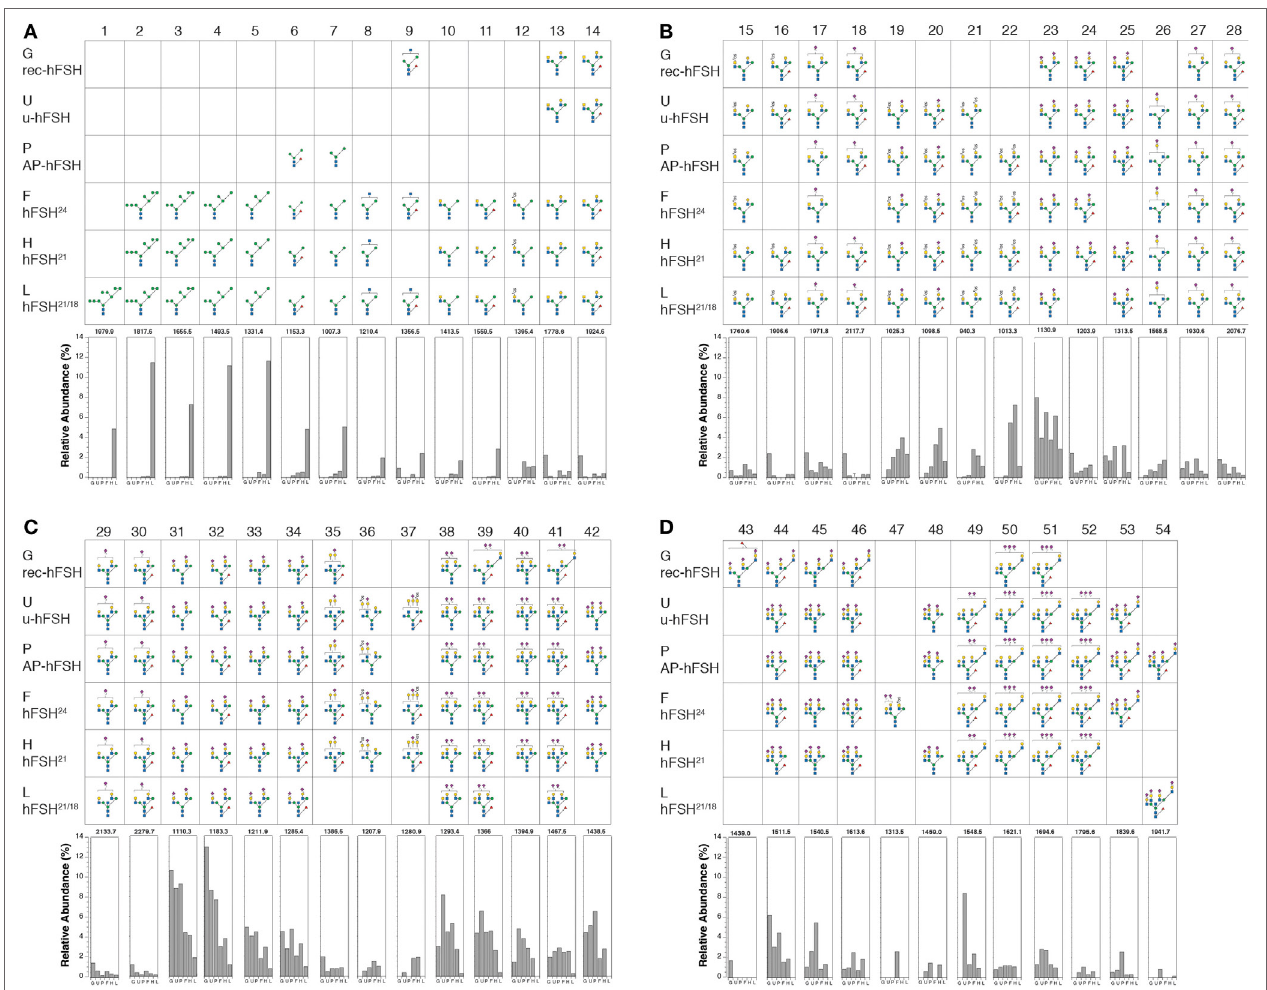
FiGURe 3 | Human follicle-stimulating hormone (FSH) oligosaccharide microheterogeneity. Summary of results of nano-ESI mass spectrometry studies showing only those oligosaccharides present at > 1% relative abundance in at least one hFSH preparation. The glycan diagram indicates it was detected in the preparation. The Consortium for Functional Glycomics monosaccharide symbols are used in conjunction with Oxford Glycobiology Institute linkage indicators (1–2, —; 1–3, \; 1–4, |; 1–6,/; solid lines indicate β -linkage and dashed lines indicate α -linkage). The bar graphs at the bottom of each panel indicate the relative abundance of the structure in each preparation. The preparations are indicated by single letters as follows: G is GH 3 -recombinant hFSH; U is urinary hFSH; P is pituitary hFSH; F is fully glycosylated pituitary hFSH 24 ; H is hypo-glycosylated pituitary hFSH 21/18 ; and L is hFSH 21/18 isolated from hLH preparations. The structures are distributed across four panels beginning with the high mannose precursors and ending with tetra-antennary oligosaccharides, the largest found in hFSH. (A) Structures 1–14. (B) Structures 15–28. (C) Structures 29–42. (D) Structures